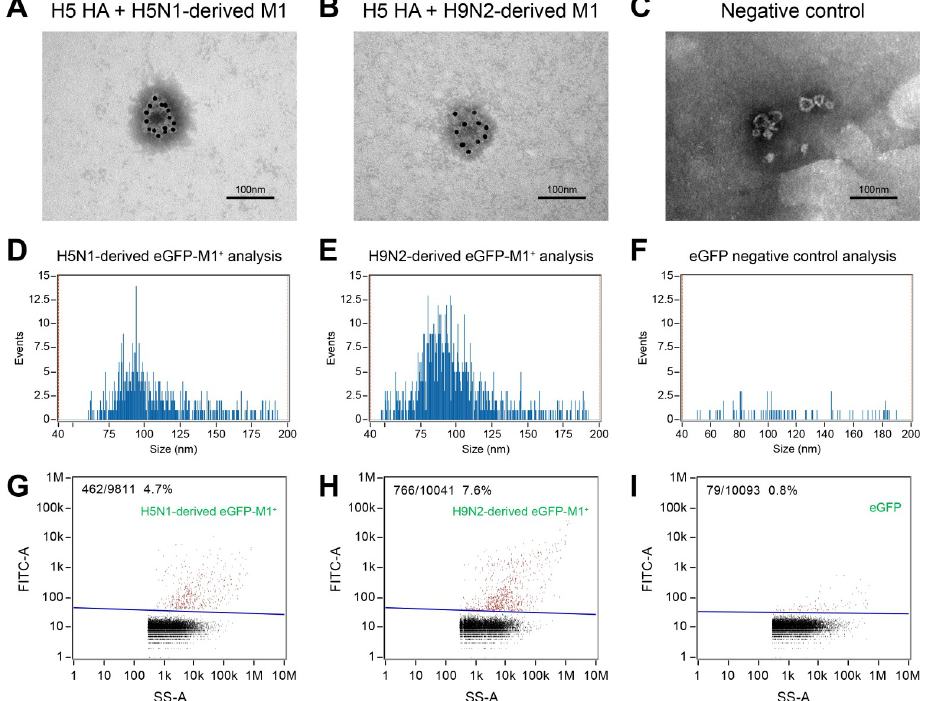
Fig 4. H9N2 virus-derived M1 protein increased viral progeny particle release in mammalian cells. (A–C) IEM analysis of influenza VLPs in the concentrated cell culture supernatant. 293T cells were co-transfected with (A)